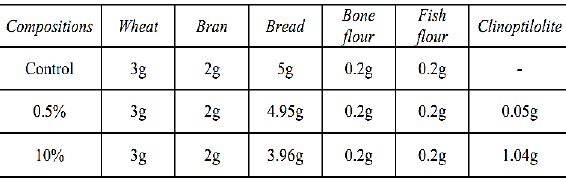
Table 2. Compositions and Ingredients of the daily ration per